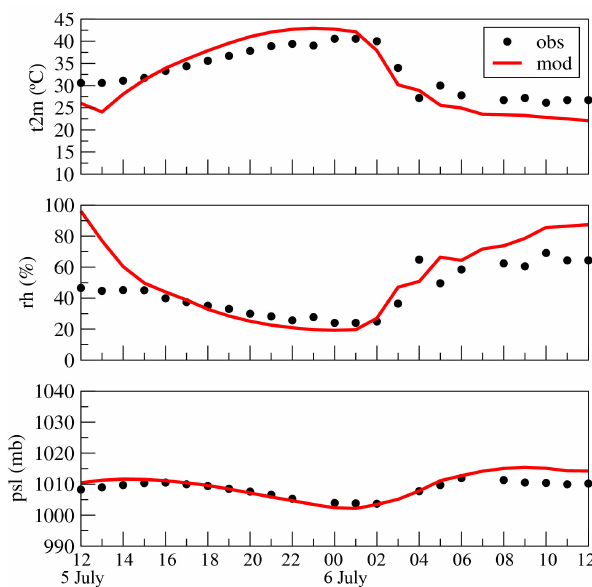
Fig. 6. NMME–DREAM and observed values at Phoenix/Sky Har- bor station, 2m temperature (upper), relative humidity (middle), and surface pressure